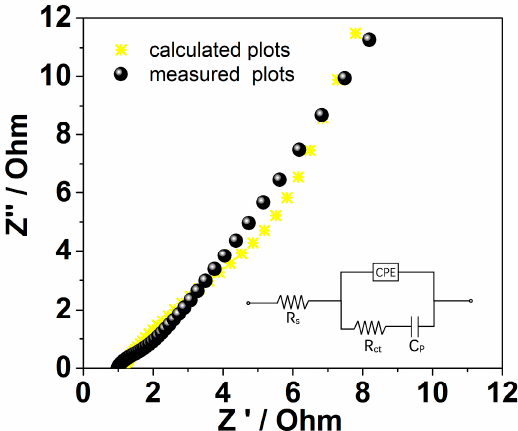
Figure 11. EIS (electrochemical impedance spectroscopy) for MnPO 4 ∙ H 2 O nanowire/GO electrode and fitting plots (inset: corresponding equivalent circuit consisting of a bulk solution resistance R s , a charge ‐ transfer R ct , a pseudocapacitive element C p from redox process of MnPO 4 ∙ H 2 O nanowire/GO, and a constant phase element (CPE) to account for the double ‐ layer capacitance).